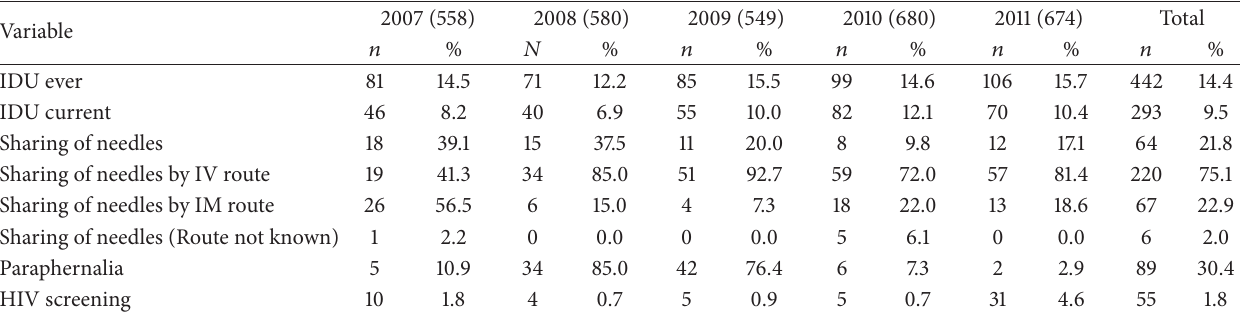
Table 2: IDU related variables of the treatment seeking middle aged individuals over the 5-year